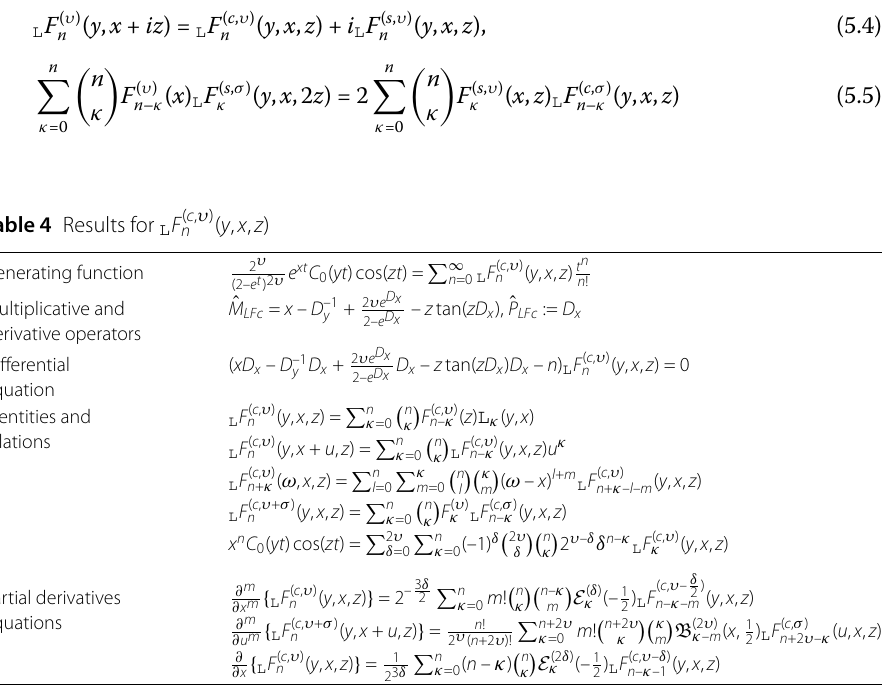
Table 4 Results for L F ( c , υ ) n ( y , x , z ) Generating